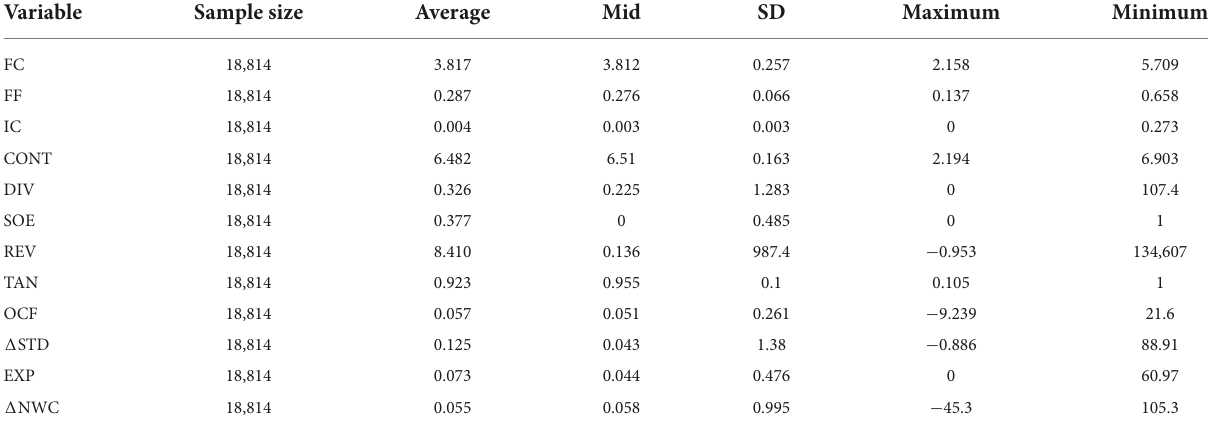
TABLE 3 Variable definition.